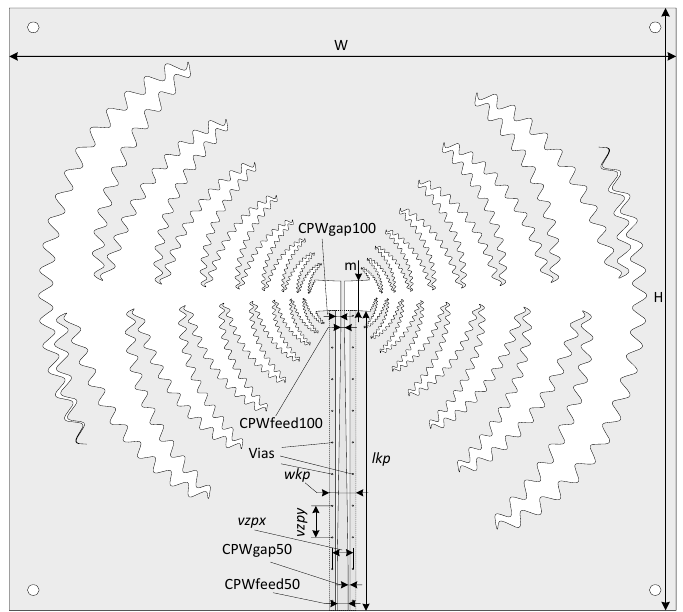
Figure 4. A model of the sinuous slot antenna: W is the printed circuit board (PCB) width, H is the PCB height.